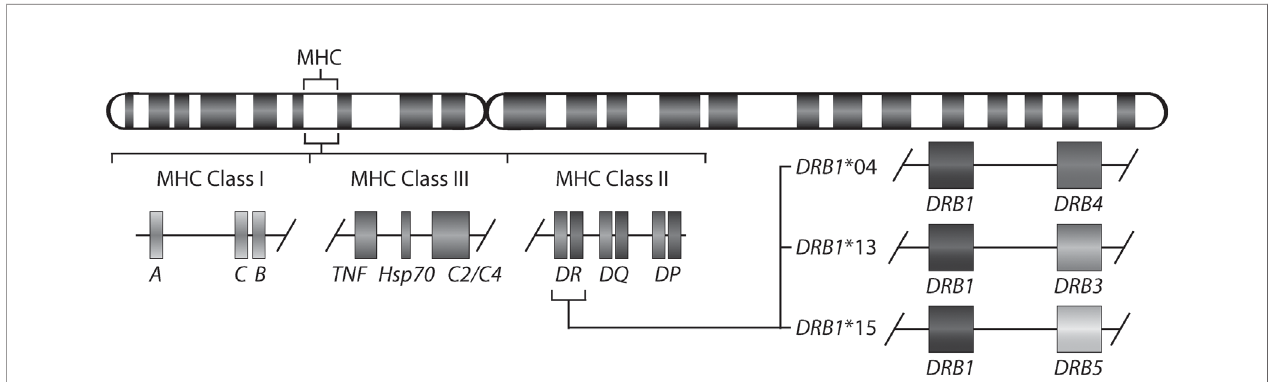
FIGURE 1 | Gene mapofthe major histocompatibility complex (MHC)region.The MHC region onthe short arm of human chromosome 6 contains the HLA-DR(HLA-DRA andHLA-DRB) molecules. The allelic variants of HLA-DRB1 ( DRB1 *04, *13, and *15) are linked with only one of the genes HLA-DRB4 , HLA-DRB3 , or HLA-DRB5